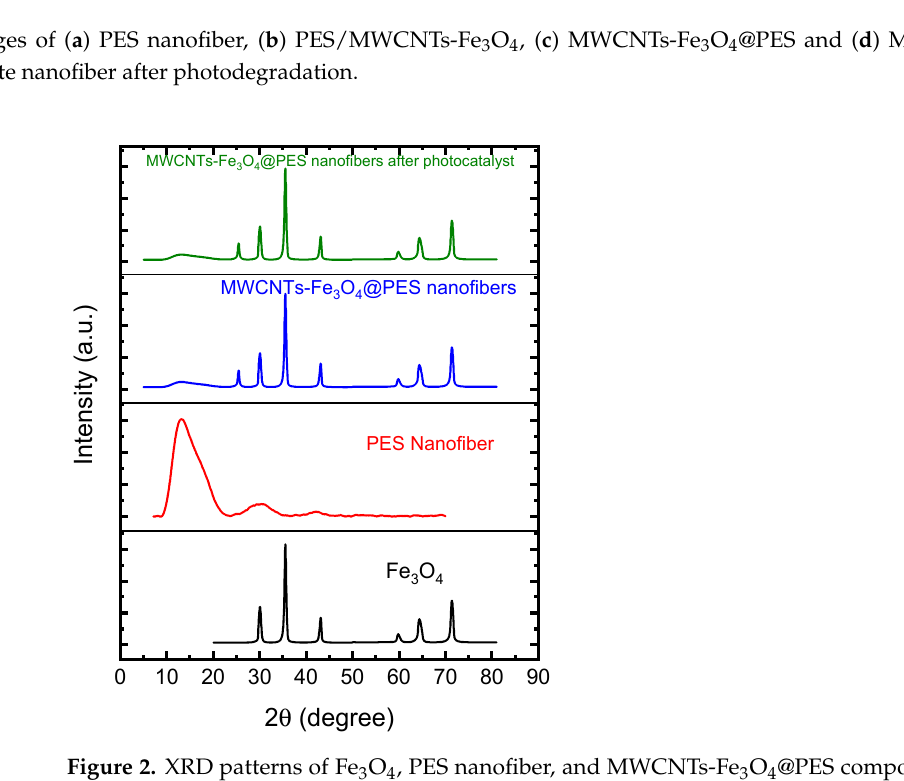
Figure 2. XRD patterns of Fe 3 O 4 , PES nanofiber, and MWCNTs-Fe 3 O 4 @PES composite nanofiber before and after photodegradation.